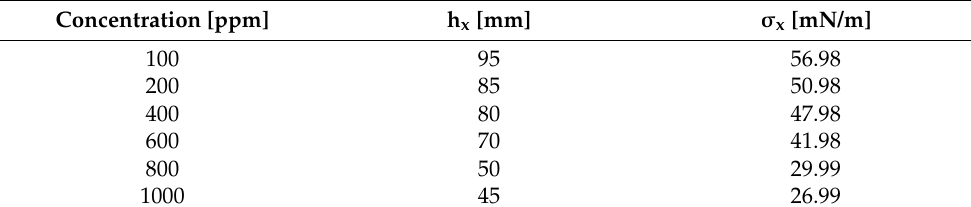
Table 5. Results of the surface tension versus the increasing solution concentration.